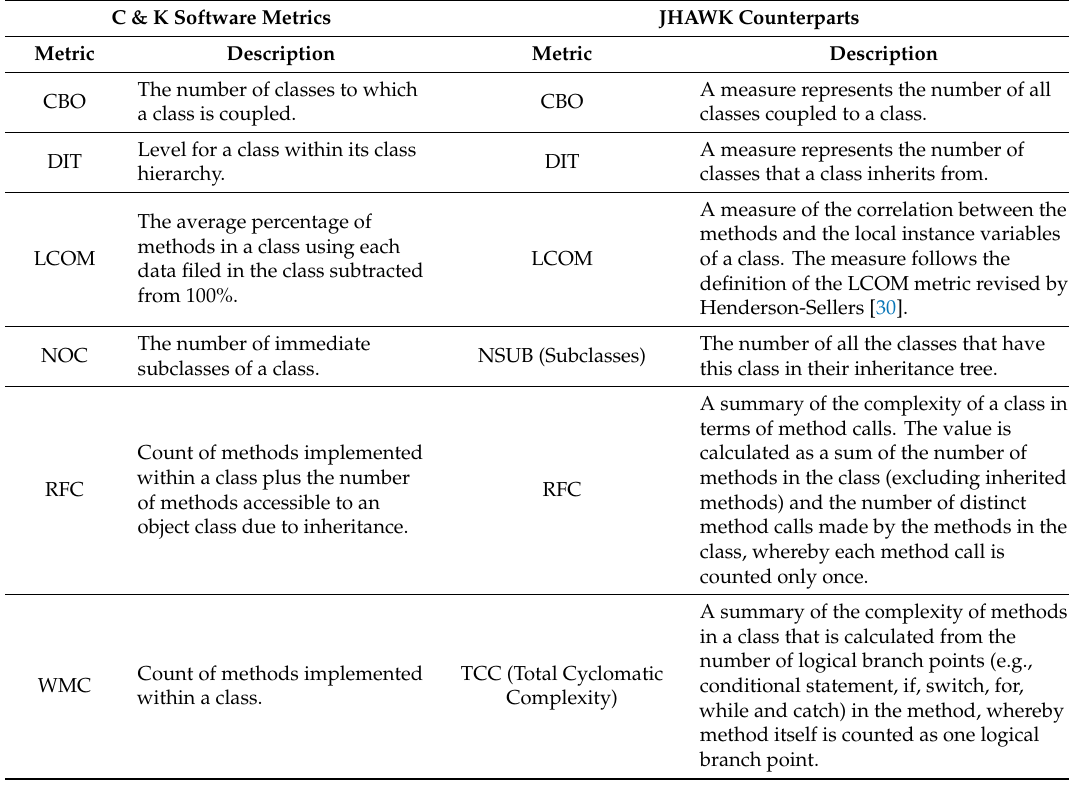
Table 1. The Chidamber & Kemerer (C&K) software metrics and their alternatives in